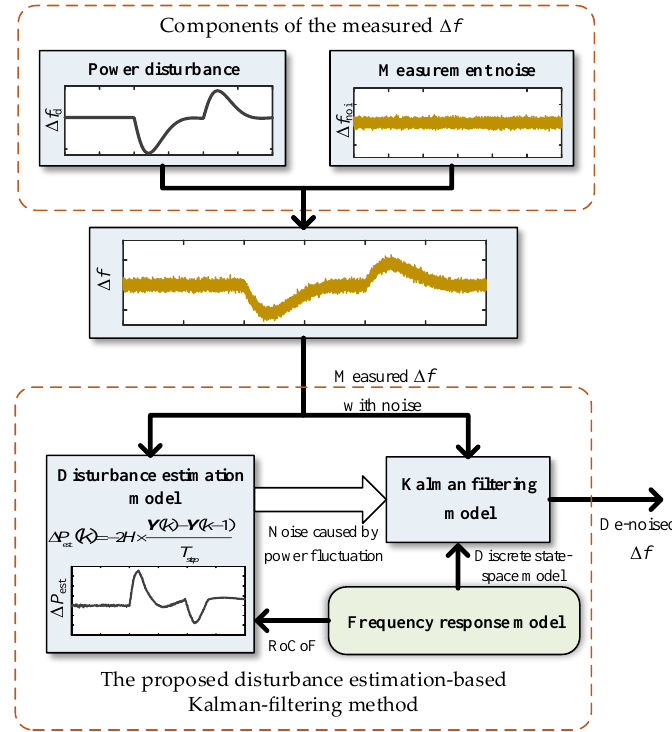
Figure 5. Framework of disturbance estimation-based Kalman filtering.